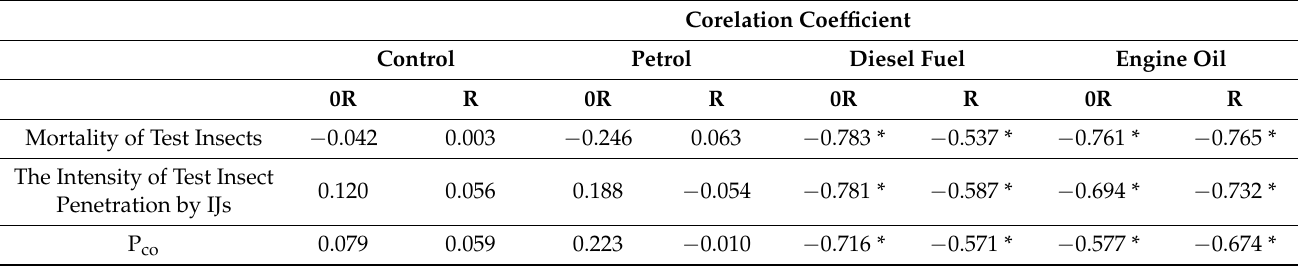
Table 4. The relationship between petroleum derivatives content in soil and nematode